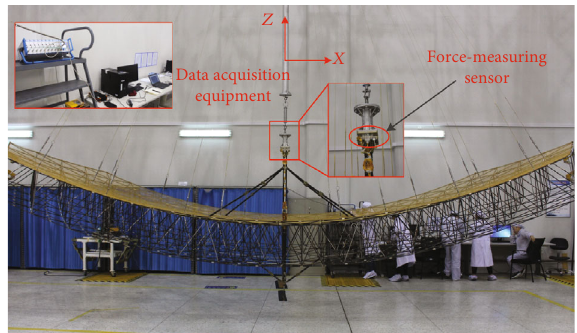
Figure 8: The impact test of re fl ector deployment.